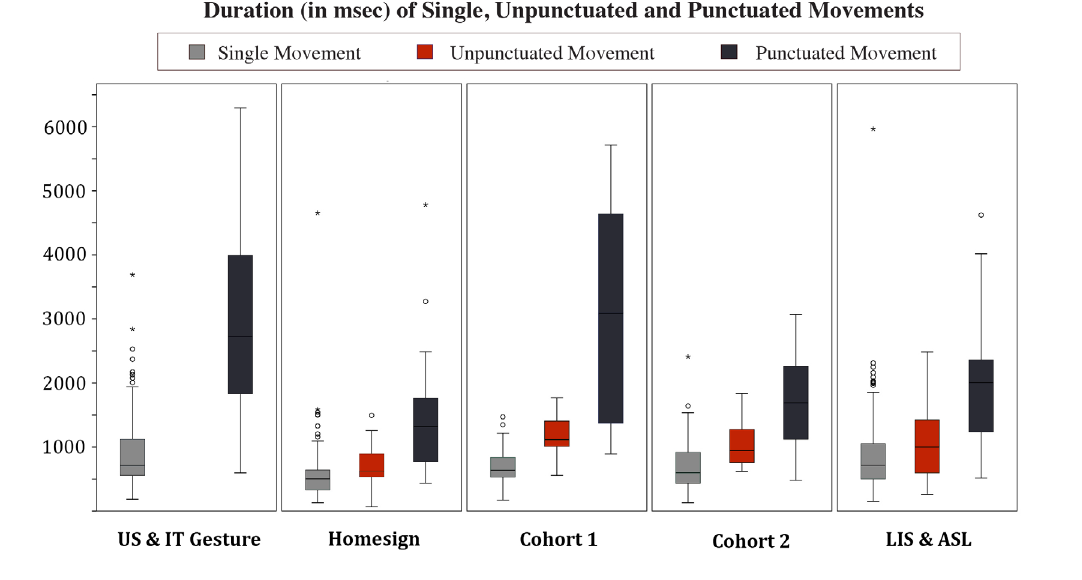
Figure 9. Mean duration (in msec) of three movement types (single, unpunctuated repetition, and punctuated repetition) for Silent Gesturers, Homesigners, NSL Cohort 1, NSL Cohort 2, and ASL/LIS. Silent Gesturers produced too few Unpunctuated Movements (see text) to analyze